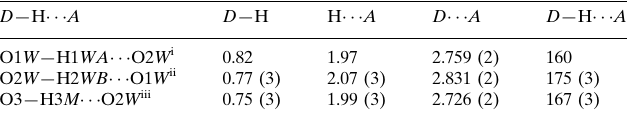
Hydrogen-bond geometry (A˚ , (cid:2)